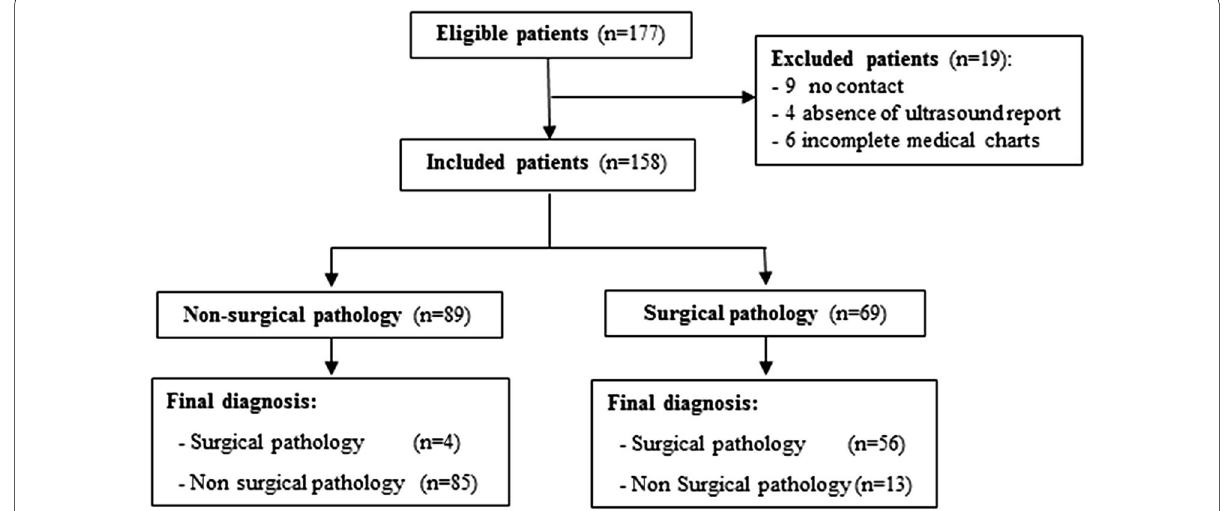
Fig. 3 STARD flow